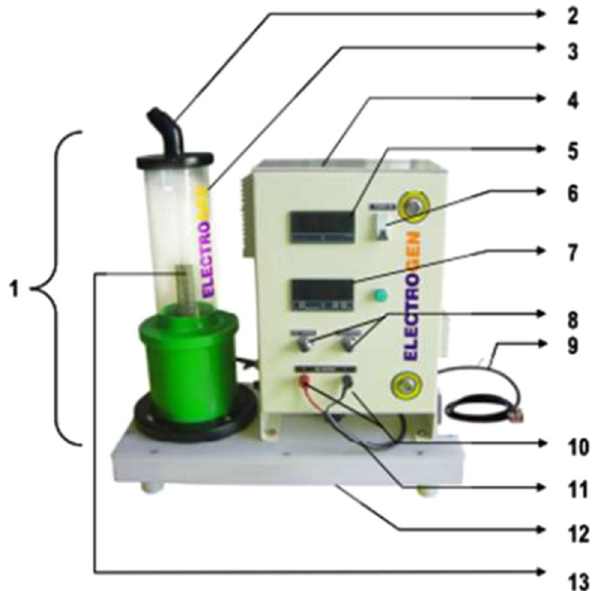
Fig. 4 EO evaluation device (1—electrolyzer (ELECTROGEN), 2— electrolyzer lid with gas vent, 3—electrolyzer tank, 4—transformer– rectifier and control panel, 5—voltmeter, 6—main switch, 7—amme- ter, 8—voltage and current adjustment knob, 9—input A/C power cable, 10—DC terminals, 11—output D/C power cable, 12—base frame and 13—electrodes assemble)